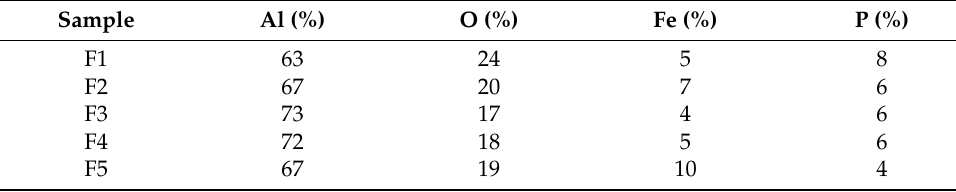
Table 3. Element content of the MAO coating under different negative